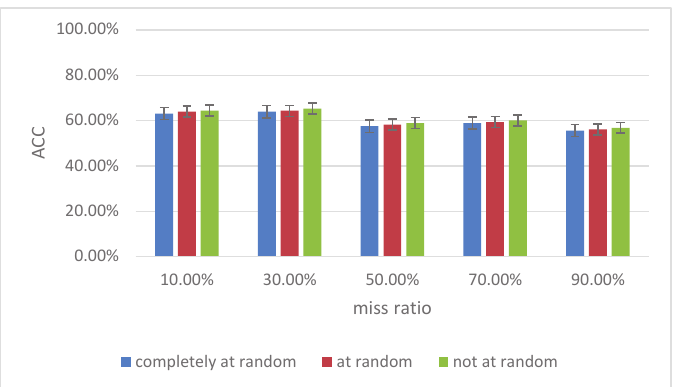
Figure 2. Comparison of ACC performance across the CANE data set with three varying types of missing data